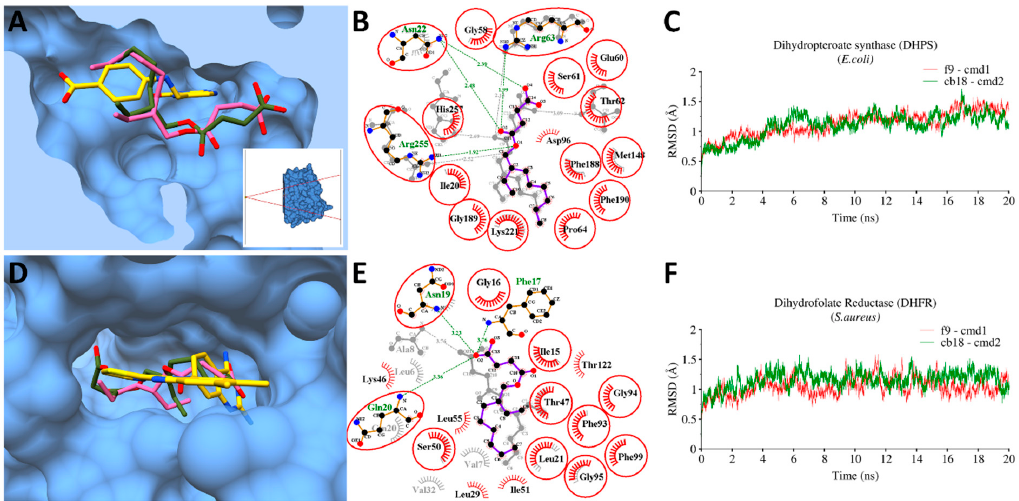
Figure 3. Molecular interactions and molecular dynamics (MD) simulations of CB18 and F9 against E. coli -Dihydropteroate synthase (DHPS) and S. aureus- Dihydrofolate Reductase (DHFR). (A) The molecular surface representation of DHPS with bound pteroic acid (gold), CB18 (pink) and F9 (green) superimposed together; (B) 2D-interaction plots with E. coli- DHPS after MD-simulations, hydrophobic interacting residues are labeled black with spiked red arc, while those interacting through H-bonds are labelled green with distance in angstrom. Conserved residues are marked with red circles; (C) root mean square deviation (RMSD) trajectory plots of E. coli- DHPS with bound CB18 (green) and F9 (red) over a period of 20 ns. The same representations of corresponding S. aureus- DHFR with bound CB18 and F9 are displayed in (D) and (E) and (F) in the same color schemes.